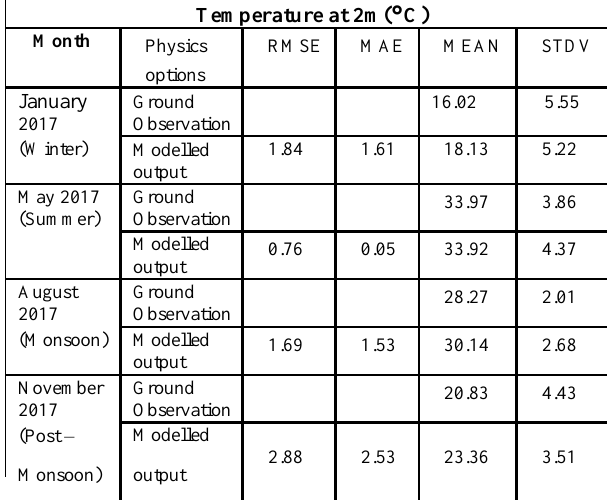
Table 4 Validation of the simulated results of